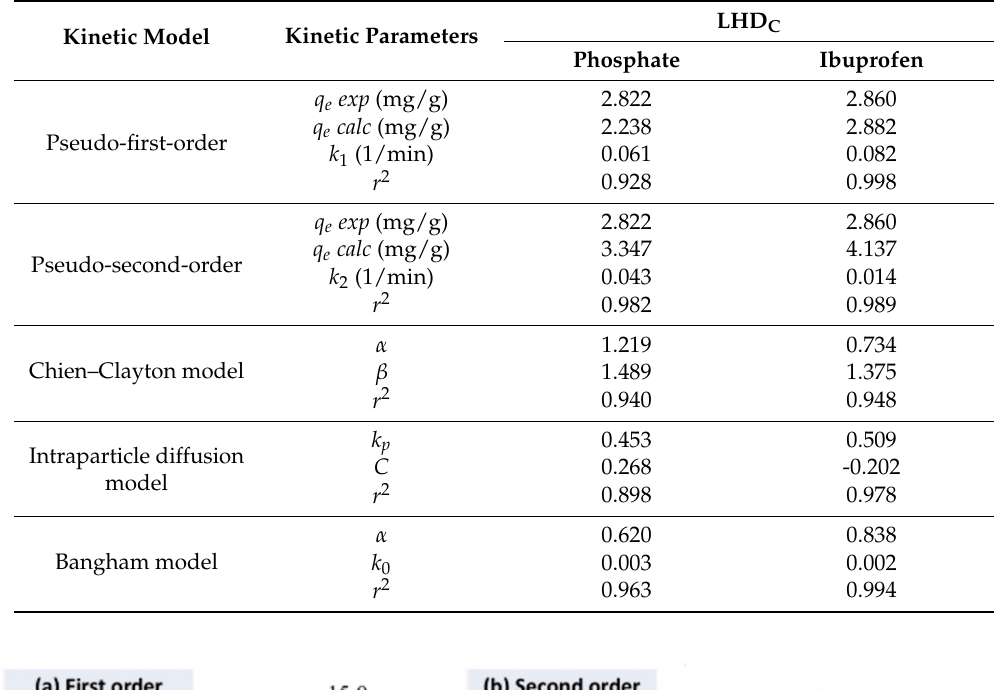
Table 4. Comparison of kinetic parameters for pseudo-first-order, pseudo-second-order, Chien– Clayton, intraparticle diffusion, and Bangham kinetic models.